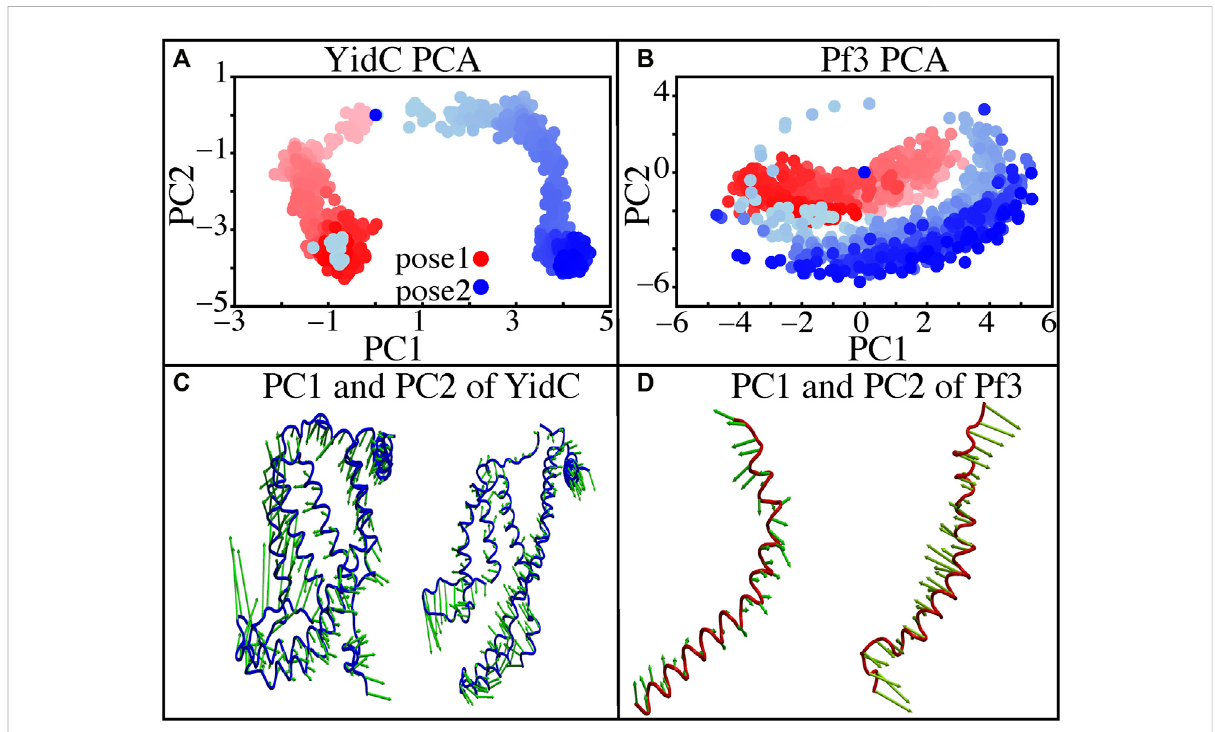
FIGURE 5 Principal component projections along PCs 1 and 2. (A,B) PC1 vs. PC2 for pose1 (red) and pose2 (blue) models of YidC and Pf3 coat protein. (C) Structural variation in PC1 and PC2 of YidC, respectively. (D) Structural variations in PC1 and PC2 of Pf3, respectively. The bidirectional arrow shows thedirectionofthe fl uctuationofthestructureandthelengthofthearrowre fl ectsthemagnitudeofthe fl uctuation. Thecolorshading inthepicture indicates a timeline, with light and dark shades representing the beginning and end of the simulation,